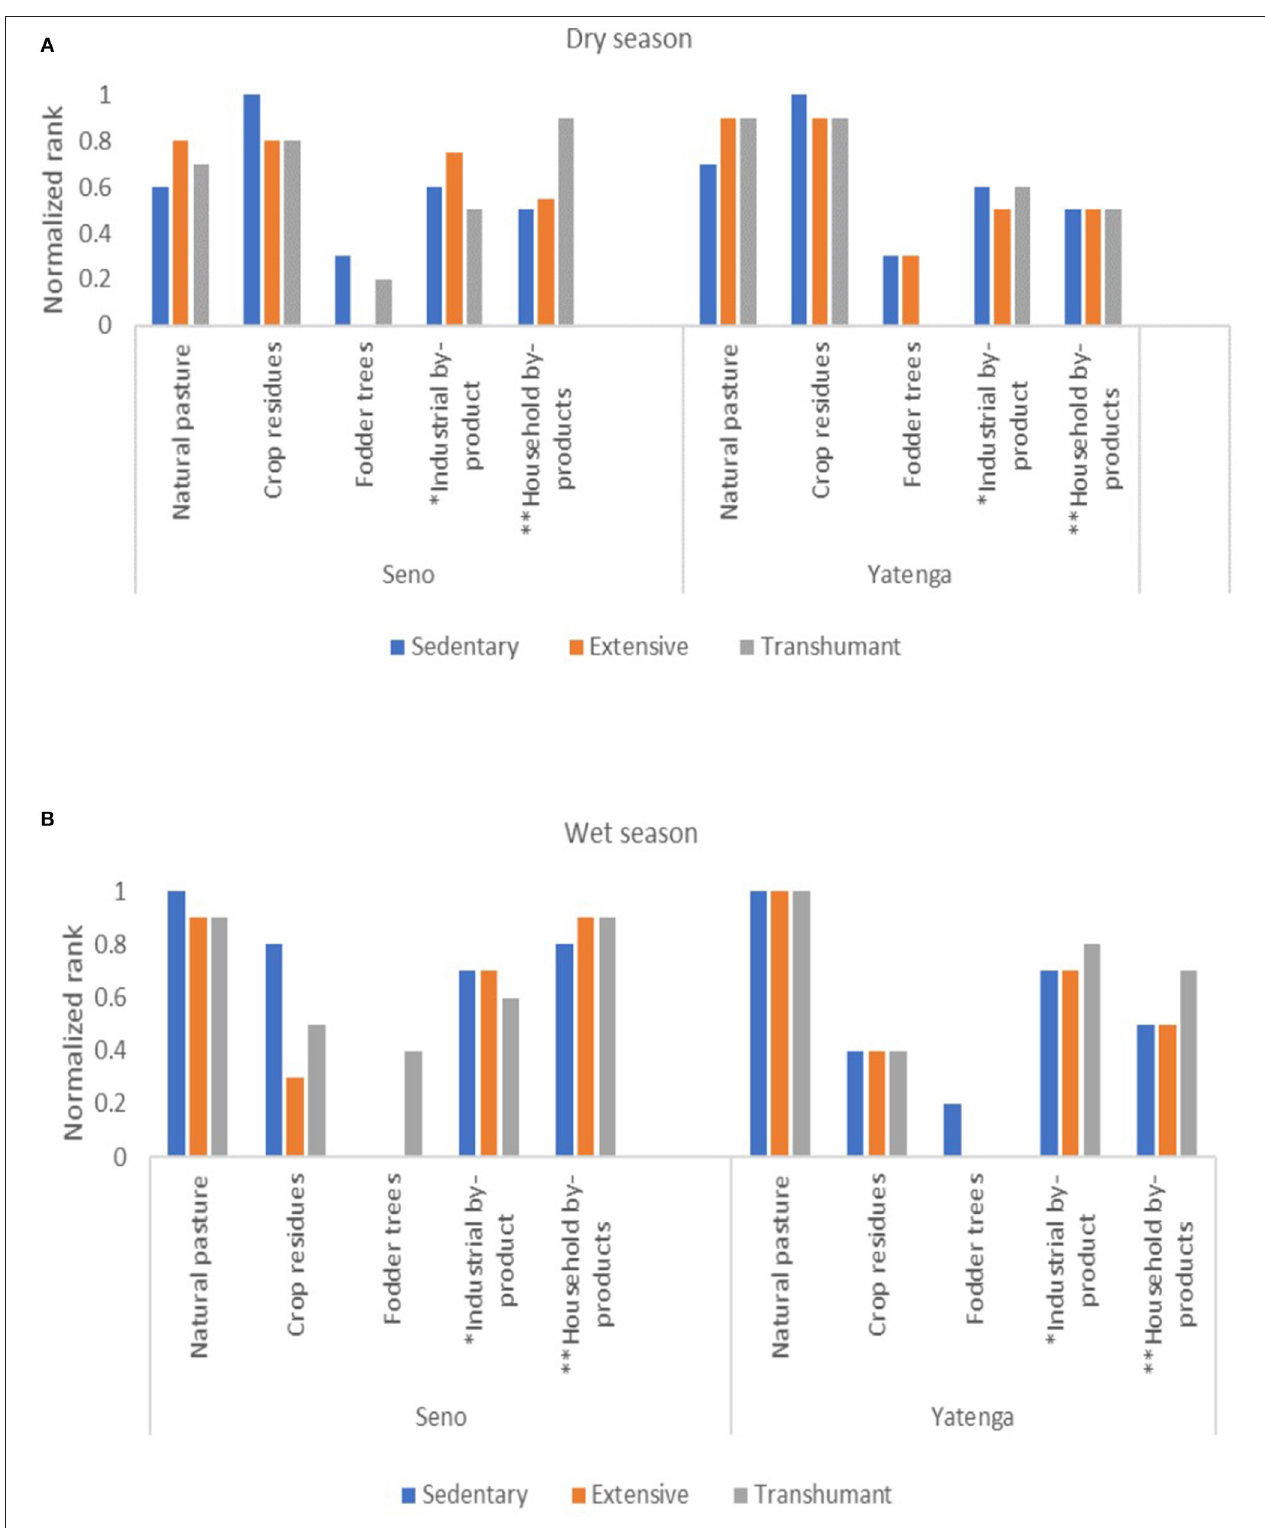
FIGURE 4 | Contribution of different livestock feed resources in both Seno and Yatenga province at (A) dry and (B) wet seasons. *Cotton seed cake; **Cereals bran.